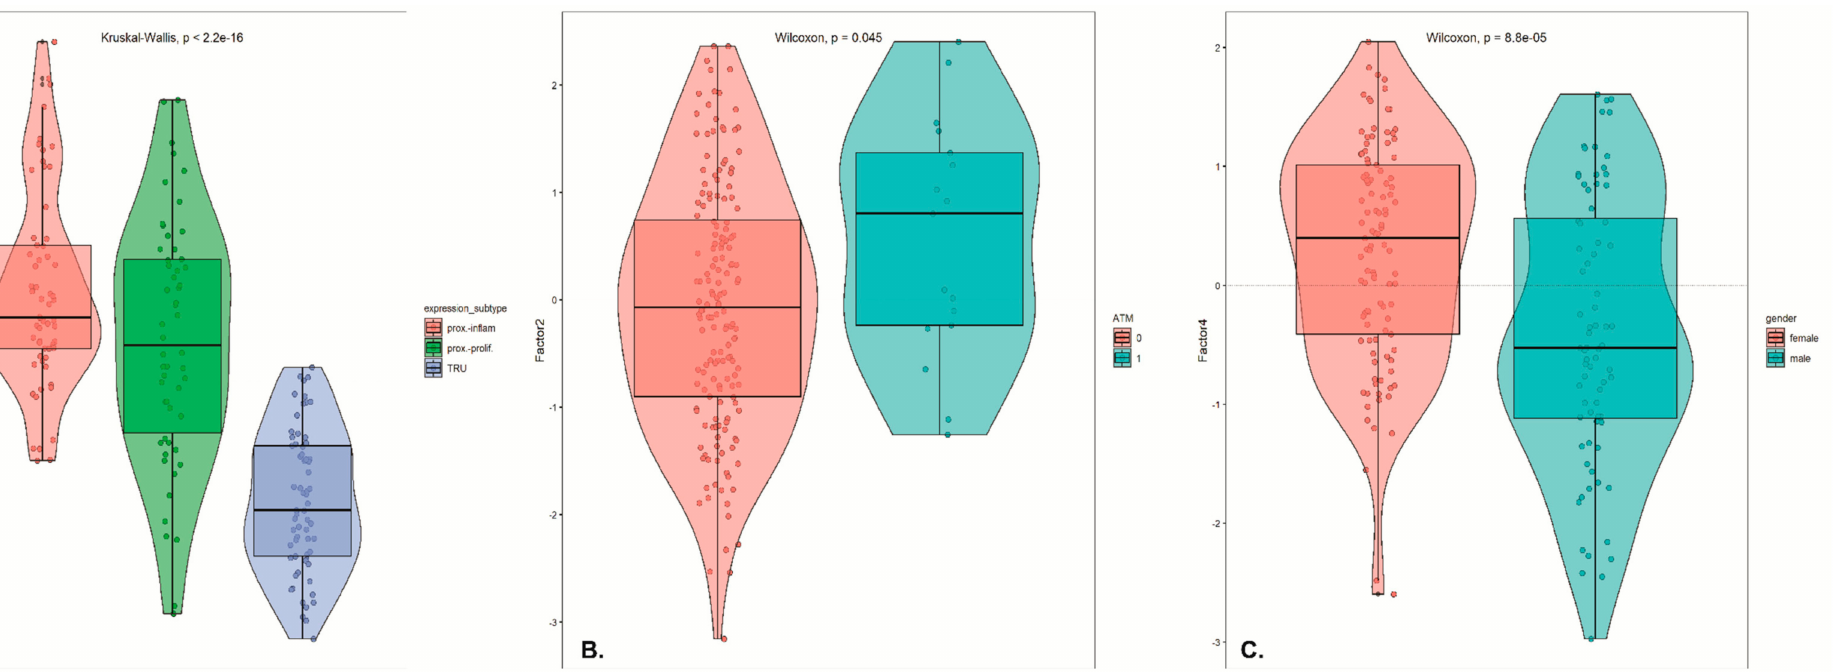
Figure 3. ( A ). Visualization of samples using Factor 1 values, which are colored by the covariate expression_subtype, which denotes the 3 available lung adenocarcinoma transcriptional subtypes. The plot shows a clear separation of the “TRU” subtype from the “proximal-proliferative” and “proximal-inflammatory”. ( B ) Visualization of the samples using Factor 2 and ATM mutation status for color. Samples with positive values have the ATM mutation *blue), whereas samples with negative Factor 2 values do not have the mutation (red). ( C ) Visualization of the LUAD samples using Factor 4 and the gender covariate to color the selected factor values. From the relative plot the significant association of Factor 4 with gender is illustrated. Samples with average positive values are mostly female and samples with negative values are mostly male. In all plots, p -values for comparison of the means of the groups were calculated using the function stat_compare_means from ggpubr R